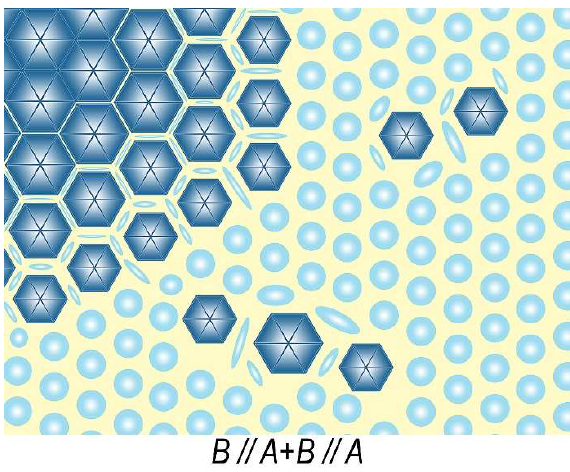
Figure 7. Appearance (schematic model) of typical microstructure on the basal plane of (Sm,Zr)(Co,Cu,Fe)z pseudo-single crystals in the high-coercivity state. The left upper angle of the scheme indicates structural component B; the bottom right angle corresponds to structural component A. The transition area (coring) A + B is between components A and B.